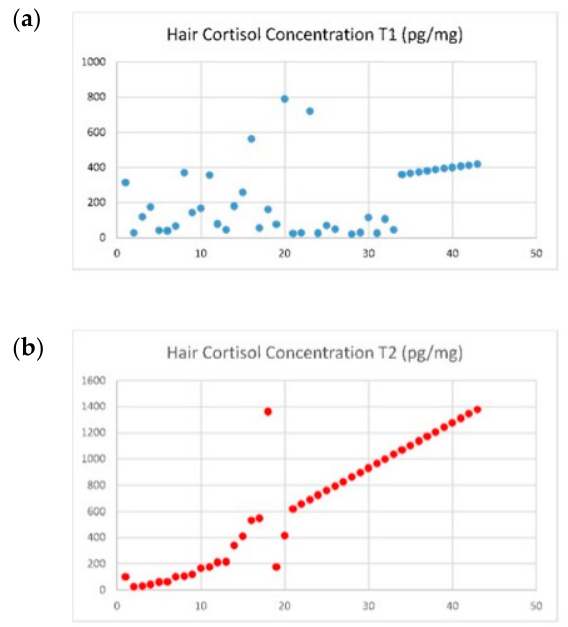
Figure 2. Evolution of HCC for the total sample. ( a ) Evolution of HCC in T1 for the total sample; ( b ) Evolution of HCC in T2 for the total sample.